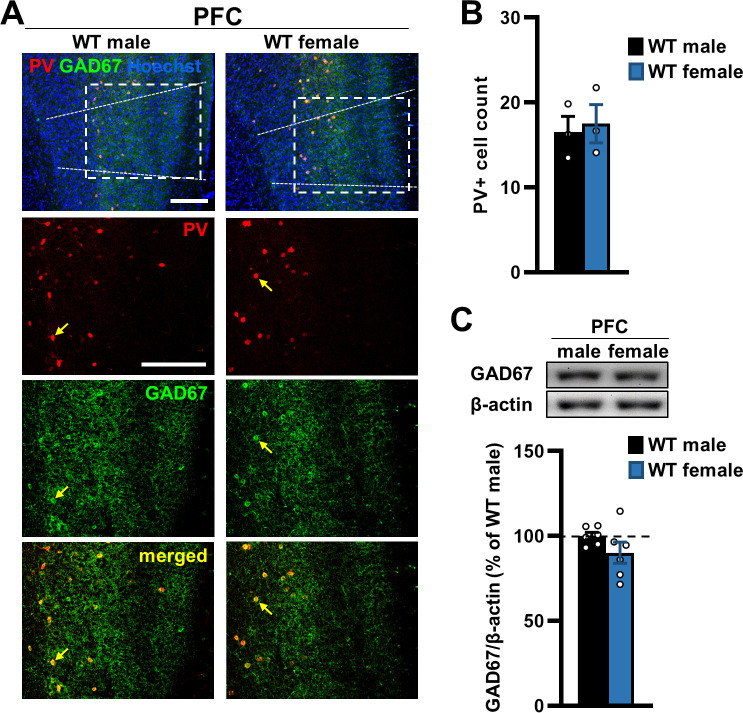
Interneuron expression in the PFC of male and female WT mice.(A) Representative immunostaining for the interneuronal markers parvalbumin (PV, red) and glutamate decarboxylase 67 (GAD67, green) in the prelimbic region of the PFC of male and female WT mice. Yellow arrows, interneuronal cell bodies co-expressing PV and GAD67. Hoechst (blue), nuclear stain. Scale bars, 200 µm. (B) Quantification of the average number of PV-positive cells in the PFC corresponding to the white box in (A) shows no difference between male and female WT mice. N = 3 mice/sex. Cell counts were averaged from five coronal sections of the PFC between 1.98 and 1.70 mm AP in one hemisphere for each mouse and from two observers blind to the experimental groups. (C) Western blot analysis of PFC lysates from WT mice shows no significant difference in GAD67 levels between sexes. β-actin, loading control N = 6/sex.